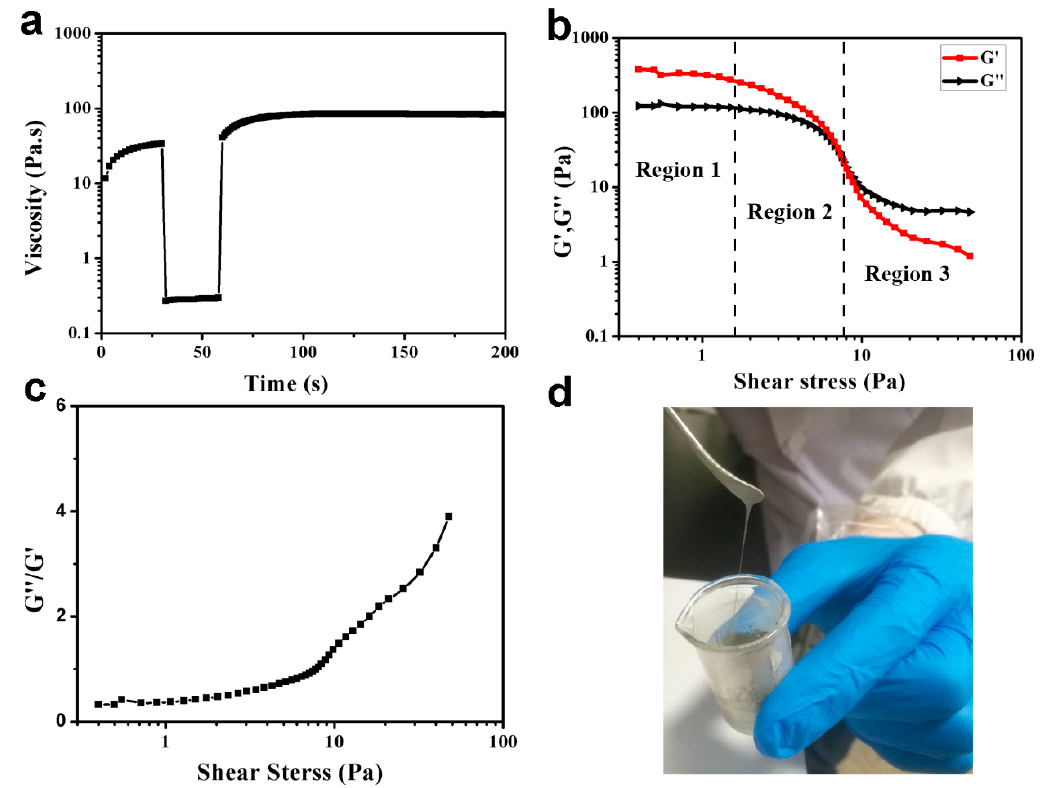
Figure 2. The rheological properties ( a – c ) and photograph ( d ) of the as-prepared Ag NWs